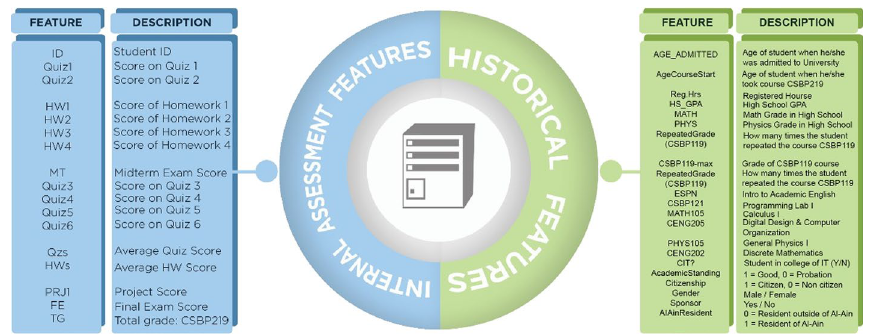
Fig. 2 Features description